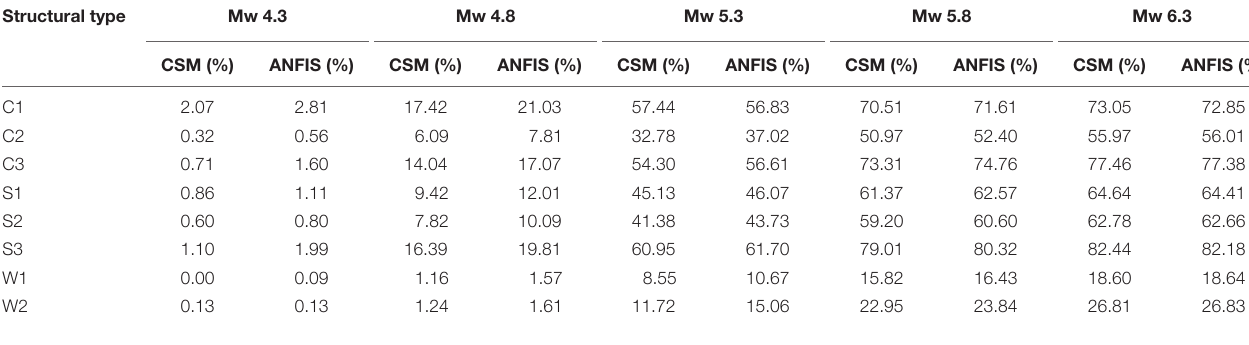
TABLE 3 | Comparison of damaged building area classified by structural type between CSM and ANFIS. Structural